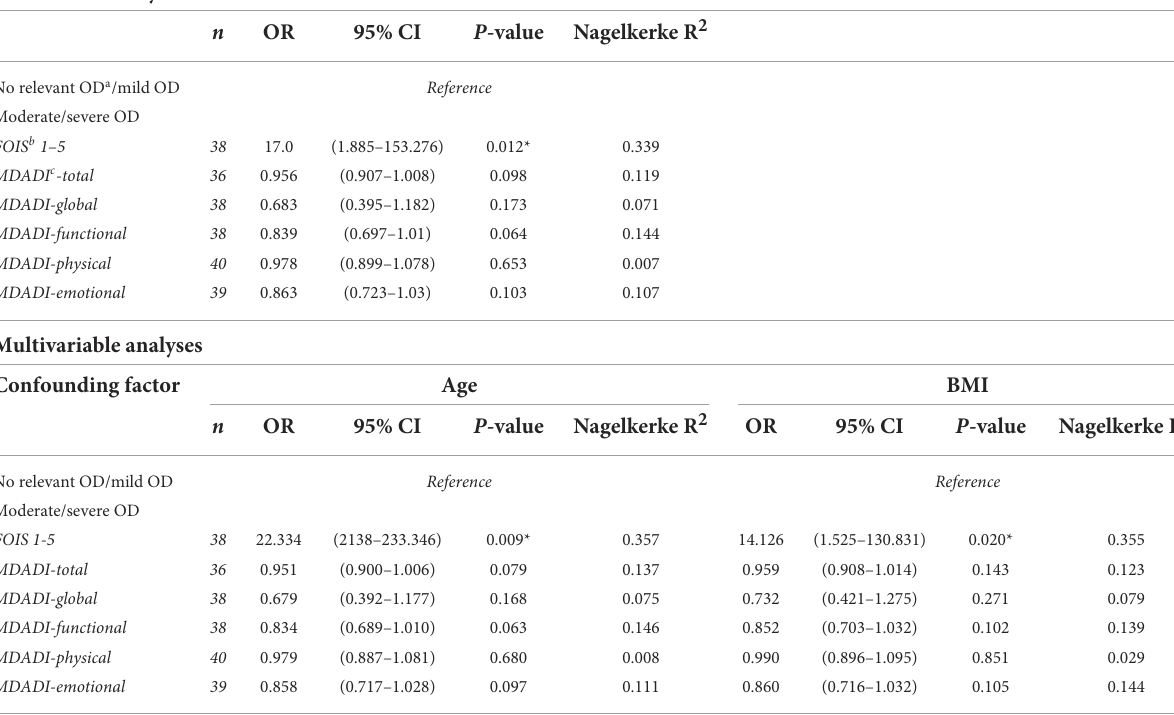
TABLE 3 Univariable and multivariable regression analyses to assess the relationship between OD severity (DSS) and respectively functional oral intake (FOIS) and patients’ dysphagia-specific QoL (MDADI). Univariable